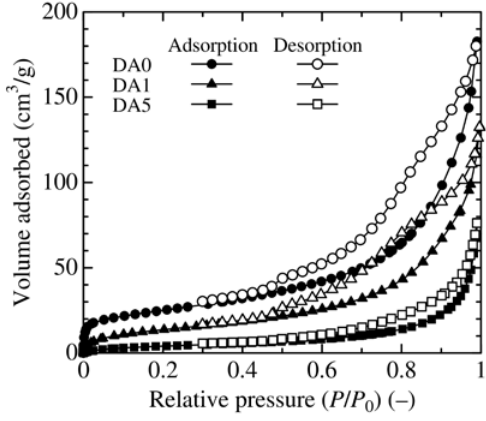
Figure 4. Nitrogen adsorption–desorption isotherms of the DA0, DA1, and DA5 samples.